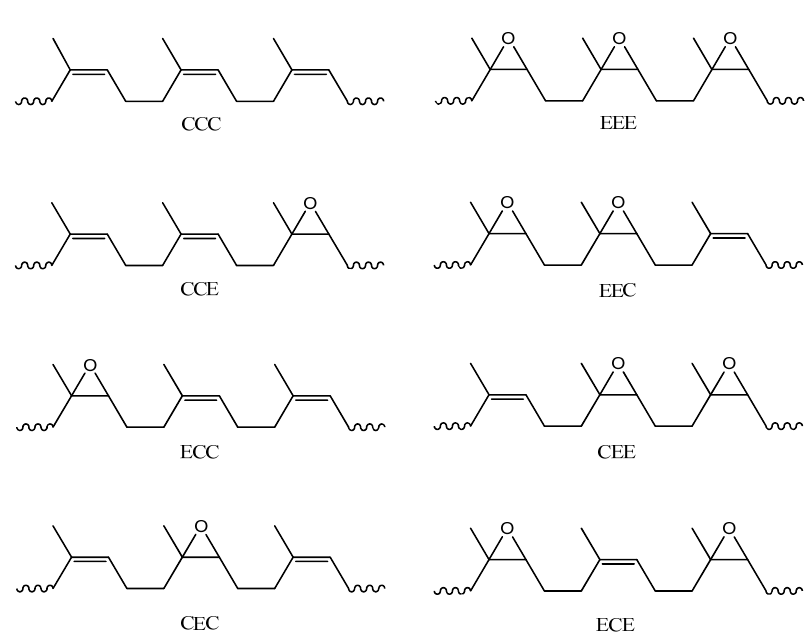
Figure 1. The possible triad sequence of